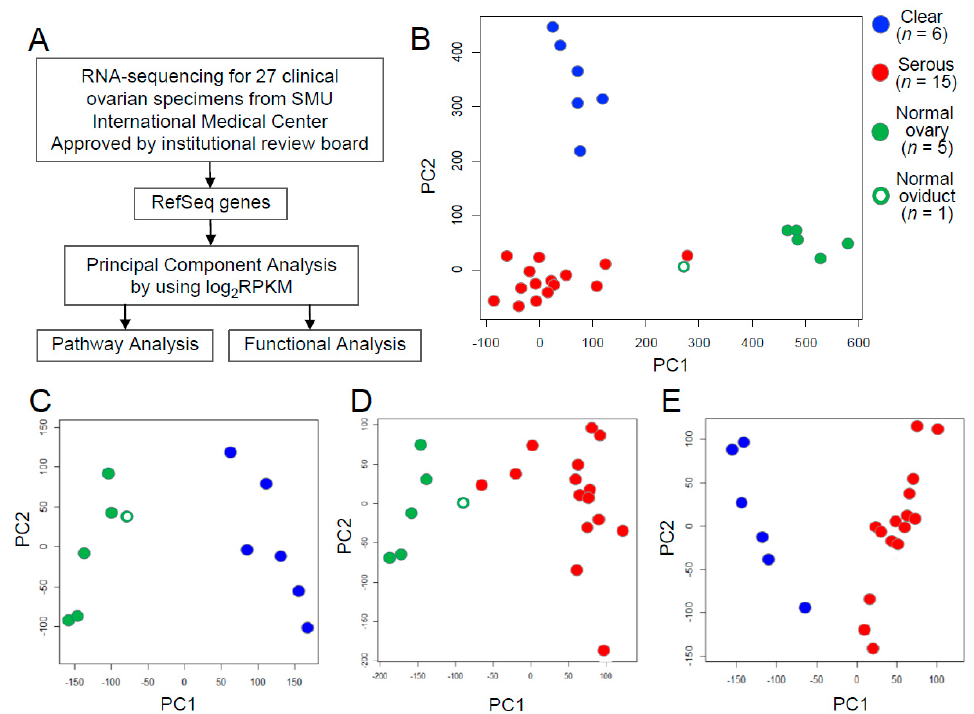
Figure 1. Principal component analysis (PCA) using log 2 read per kilobase of transcript length per million mapped reads (RPKM) of RefSeq genes showed transcriptomic di ff erences among pathological groups. ( A ) Schematic presentation of transcriptomic and functional analysis of ovarian cancer performed in this study. Briefly, RNAs were isolated from 27 clinical ovarian specimens and analyzed by RNA sequencing. Based on the log2RPKM values for each RefSeq gene, PCA using log2RPKM of Refseq genes was performed. Then, functional analysis using small interfering RNA (siRNA) was also performed. ( B ) Plot of the first two components from PCA of the log2RPKM of RefSeq genes. The prcomp function of R-package was used for the PCA of clear cell carcinoma (CCC) ( n = 6), high-grade serous carcinoma (HGSC) ( n = 15), and normal tissues ( n = 6). PC1, 1st principal component; PC2, 2nd principal component. ( C ) Plot of the first two components of the CCC and normal tissue groups. ( D ) Plot of the first two components of the HGSC and normal tissue groups. ( E ) Plot of the first two components of the CCC and HGSC groups. CCC and HGSC are indicated by blue and red solid circles, respectively. Normal tissues are indicated by green circles, with the solid ones representing normal ovary tissues and the open ones representing normal oviduct